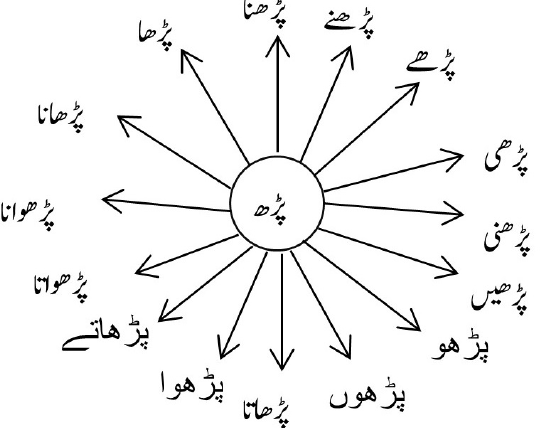
(cid:235)(cid:8)(cid:81)(cid:75)(cid:18) ” -/parh/ (read).